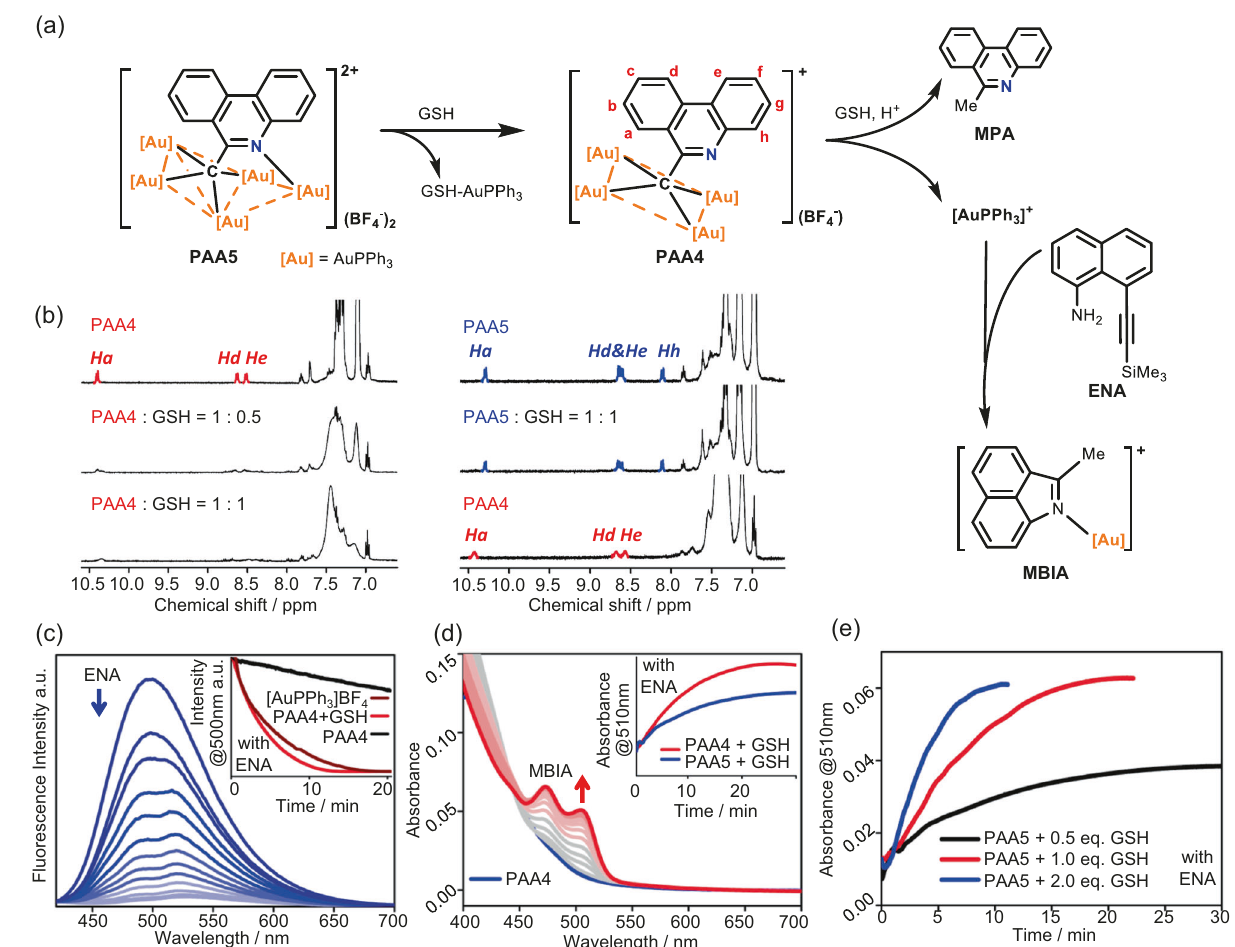
Fig. 3 | Reactivity studies of PAA4 and PAA5 with GSH. a Schematic reaction procedures of PAA4 and PAA5 with GSH and the ENA-to-MBIA transformation triggered by active Au(I) species. b 1 H-NMR spectra monitoring (DMSO-d 6 :D 2 O= 9:1, 298K) on the reaction mixture of PAA4 /GSH (left) and PAA5 /GSH (right) in different ratios. c Fluorescence spectrum monitoring ( λ ex =380nm) on the reac- tion mixture of PAA4 :ENA:GSH=1:0.5:1 ( c PAA4 =3.3 × 10 − 5 M, MeOH:H 2 O=1:1, 298K) in the presence of HBF 4 ( c HBF4 =1.0 × 10 − 4 M). Inset: Fluorescence variation curvesat500nm( λ ex =380nm)correspondingtothedecreaseofENA( c ENA =1.6× 10 − 5 M) upon its reaction with PAA4 ( c PAA4 =3.3 × 10 − 5 M), [AuPPh 3 ]BF 4 (1.3 ×